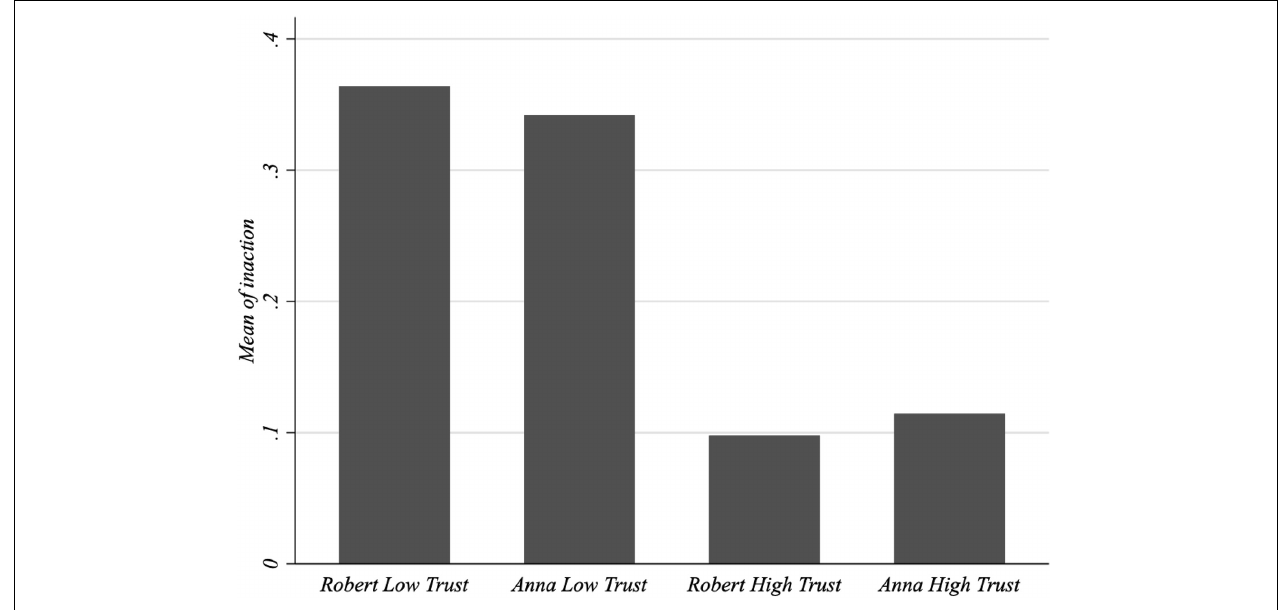
FIGURE 3 | Frequency of treatment-avoiding advice. Frequency of treatment-avoiding advice in the vignettes.